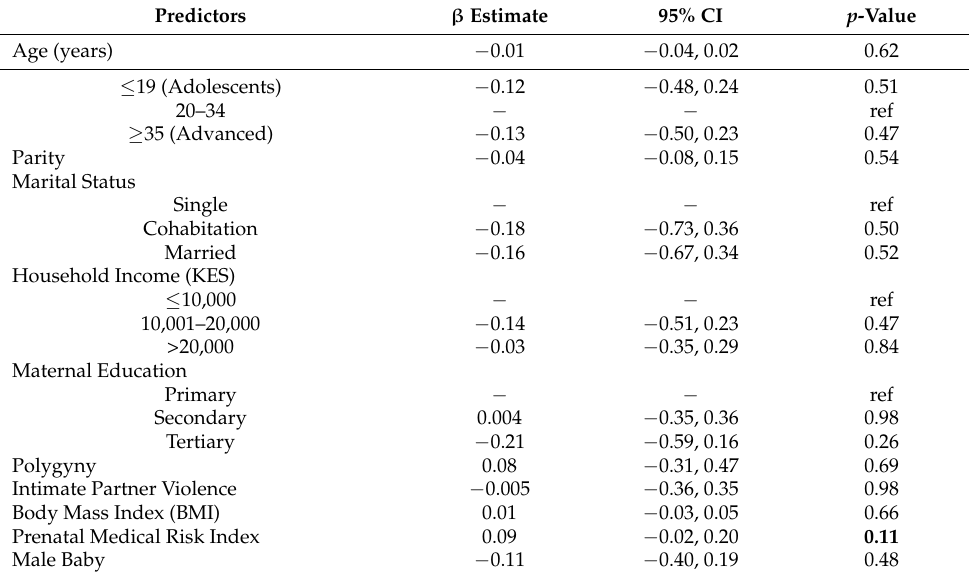
Table A3. Results of bivariate analysis between socio-demographic predictors and hair cortisone concentration (HCNC).